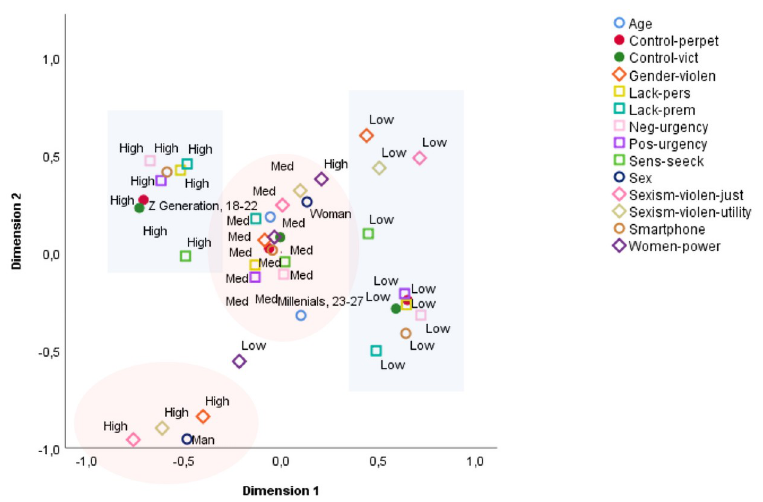
Fig 2. Diagram showing the distribution of the variables in a two-dimensional